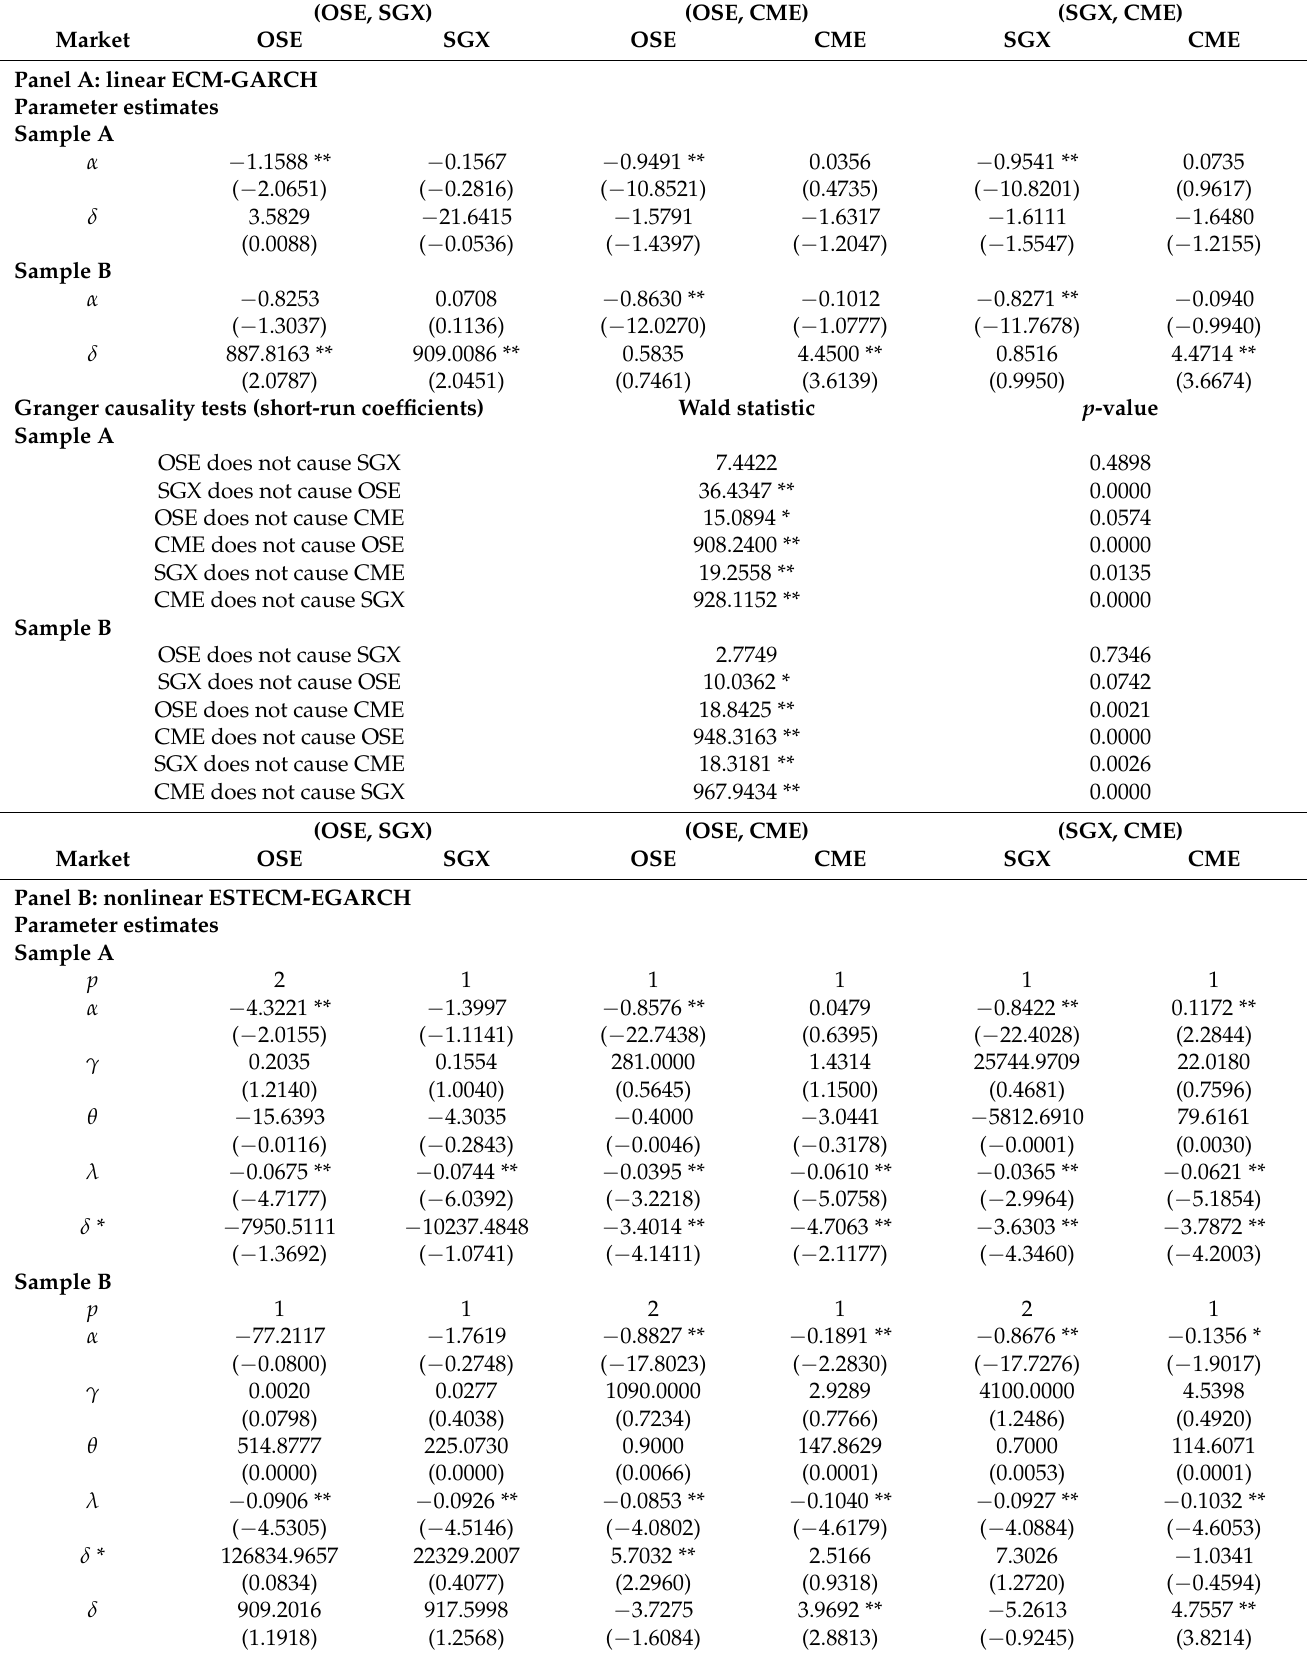
Table 7. The cross-border futures price dynamics with